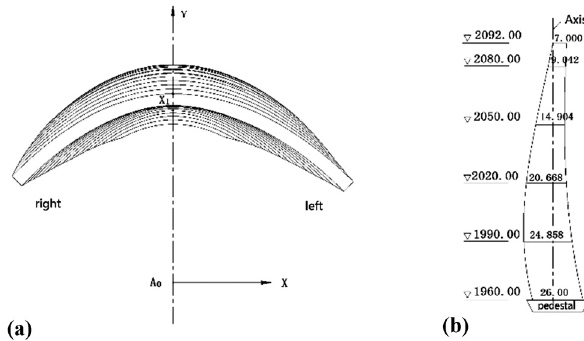
Figure 1: Geometric fi gure of Lizhou arch dam. ( a ) Plan of arch dam and ( b ) section view of crown